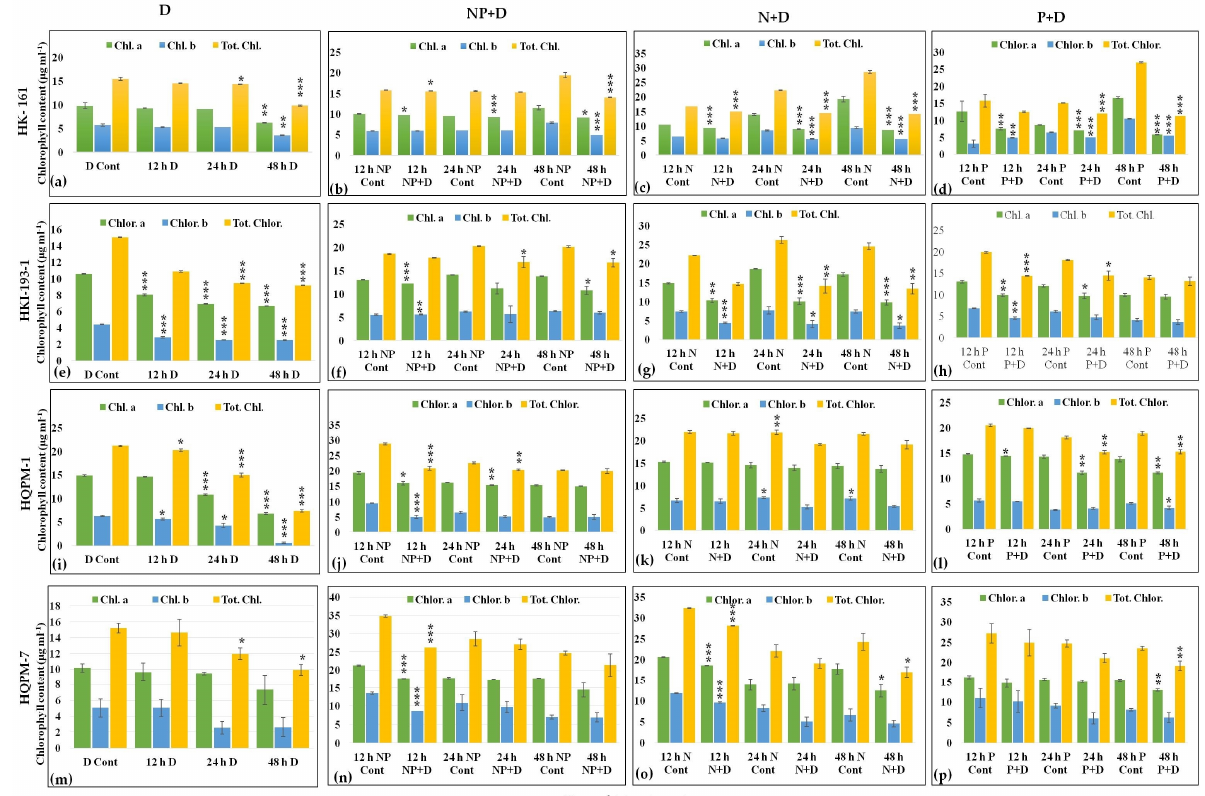
Figure 4. The effect of nutrient application on the chlorophyll content of maize seedlings under control (cont) and drought stress (D) conditions without or with pre-supplementation with nitrogen (N) and/or phosphorous (P). The graphs show average values of changes in HKI-161 ( a – d ), HKI-19-1 ( e – h ), HQPM-1 ( i – l ) and HQPM-7 ( m – p ) maize genotypes. The mean values and standard error obtained using three biological replicates are plotted. Asterisks indicate significant statistical differences: *** p < 0.001, ** p < 0.01, * p < 0.05.